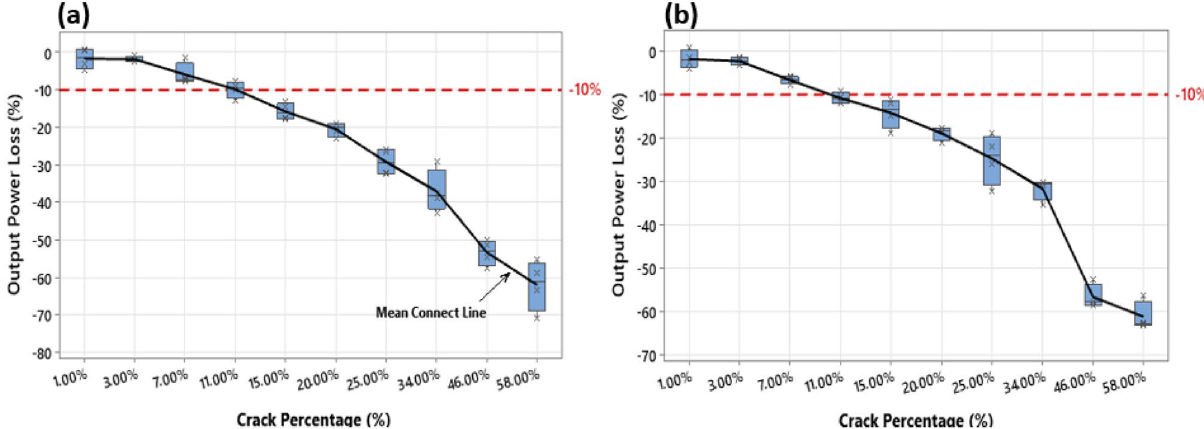
Figure 6. Calculation of the output power loss for the tested cracked solar cell samples ( a ) at 1 Sun, ( b ) at 0.5